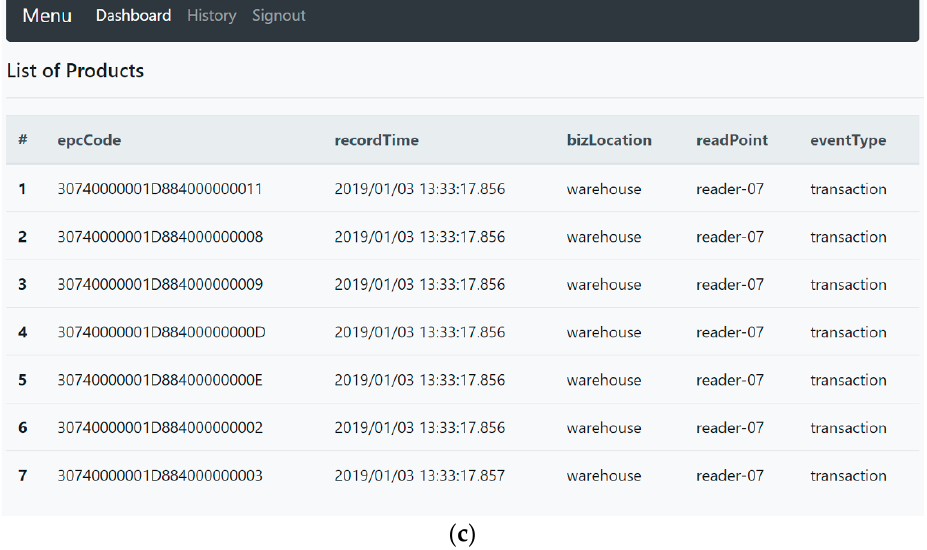
Figure 8. Prototype of real-time monitoring system: ( a ) System architecture, ( b ) client program to filter false positives, and ( c ) web dashboard presents the delivered products.